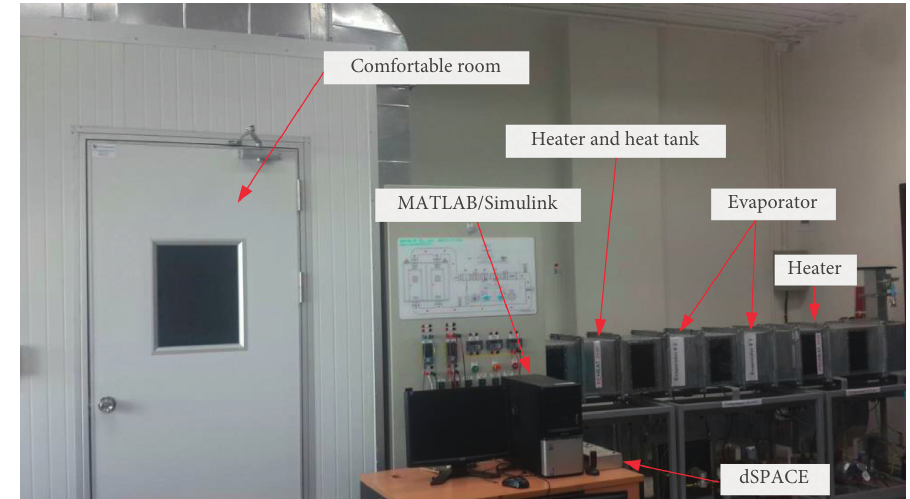
Figure 8: Experimental research